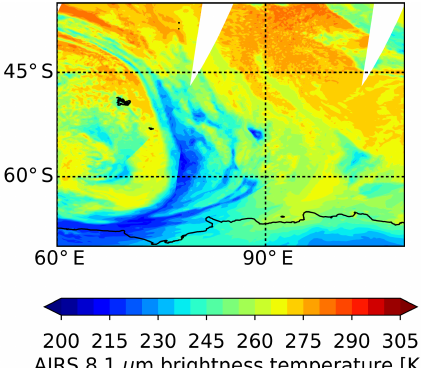
Figure 9. 8.1µm brightness temperature measurements of AIRS for a non-orographic gravity wave event over the southern Indian Ocean on 8 August 2007. Low brightness temperatures indicate the pres- ence of high clouds associated with a storm system in the study